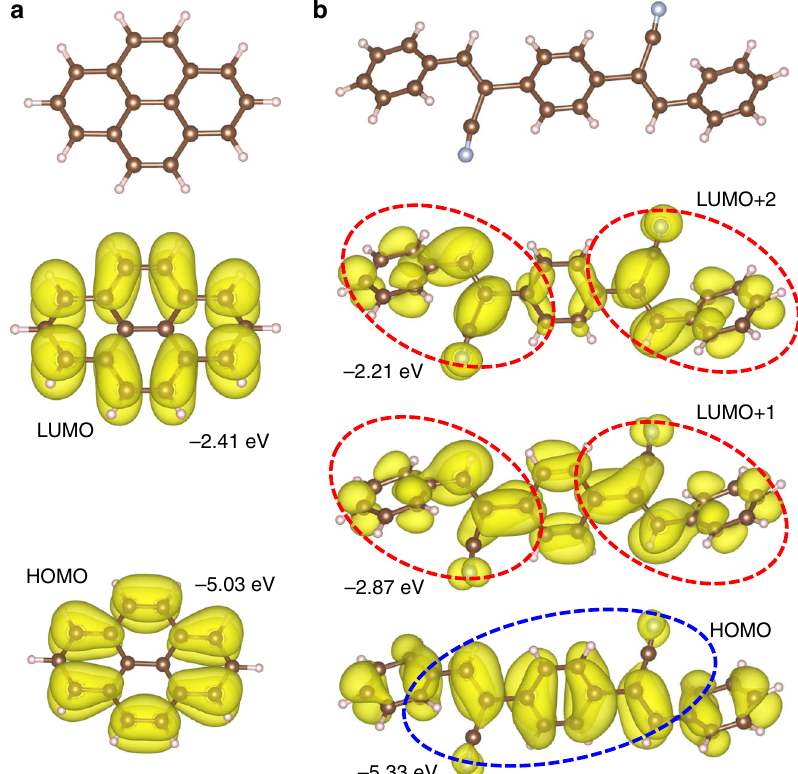
Fig. 3 Molecular information. MO energy levels and the associated wavefunctions of a a Py and b a BCSB molecule. The red and blue ellipses highlight the charge localization of LUMOs and HOMO,